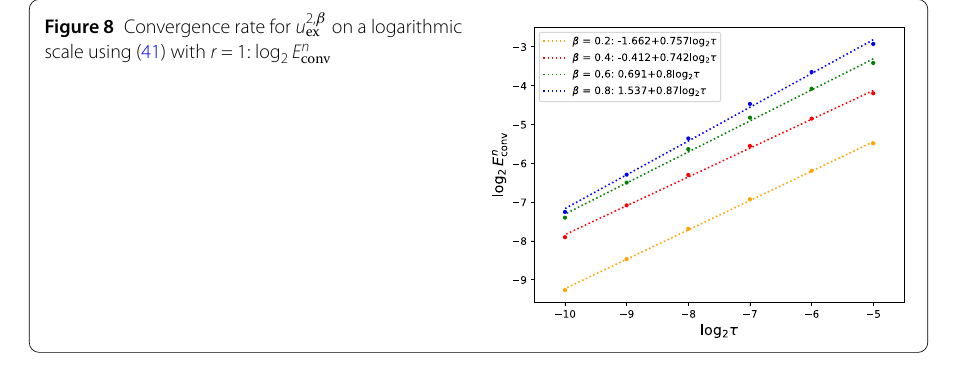
Table 3 Errors and order convergence for u 1, β ex using (42) with r = 2– β r = 2– β β n = 32 β =